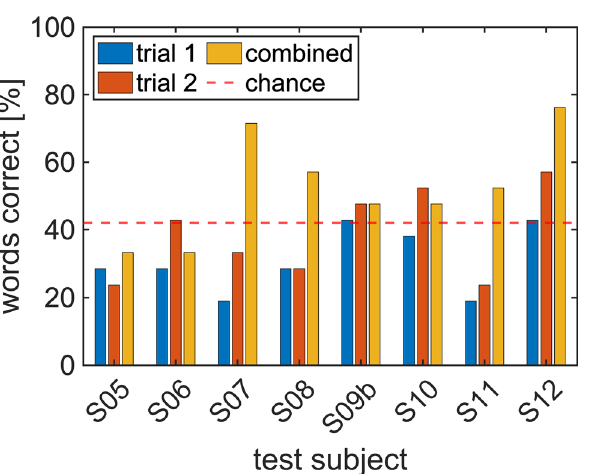
Figure 3. The results from each subject. Recognition scores often have higher than 50% recognition rates. Some test scores are near 50% correct, and for recognition, close to 80%. Chance was at 42.5%. Initially, only the BEDCS was available to us for testing. Subjects S1–S9 were tested with this system. The forced-choice comparisons were only completed in S5–S9. Table 1 (cumulative results) and STable 1 (individual results) show the subjects’ performance on the